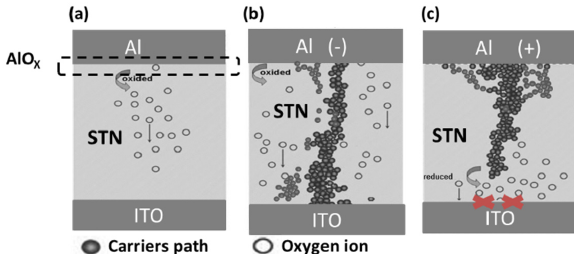
Figure 2. Possible resistive switching mechanism of the Al/STN/ITO device. ( a ) Thermal equilibrium; ( b ) Negative bias at the Al side; and ( c ) Positive bias at the Al side.